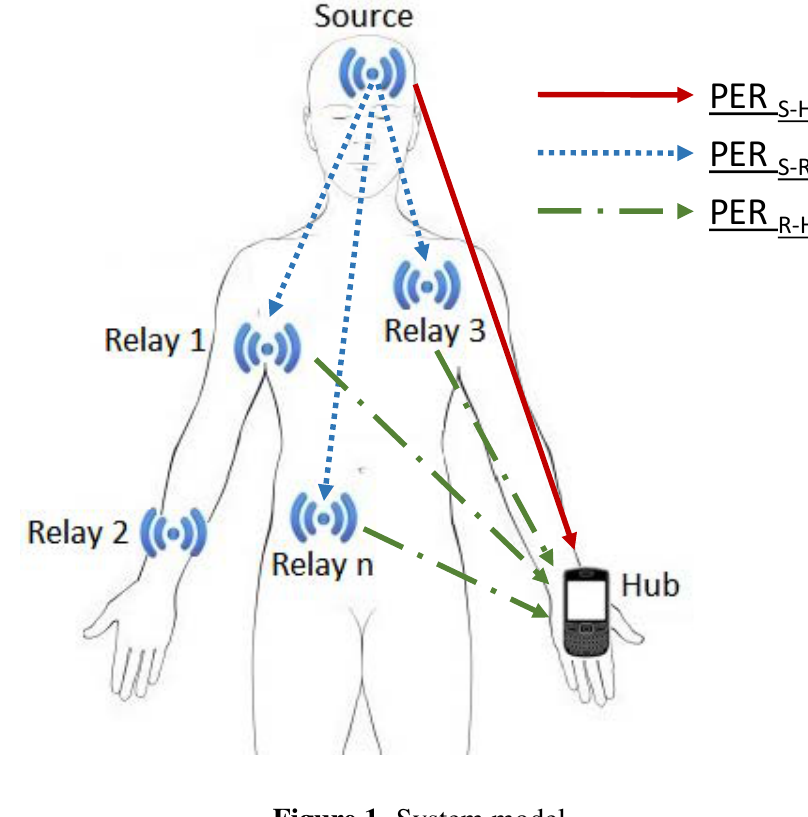
Figure 1. System